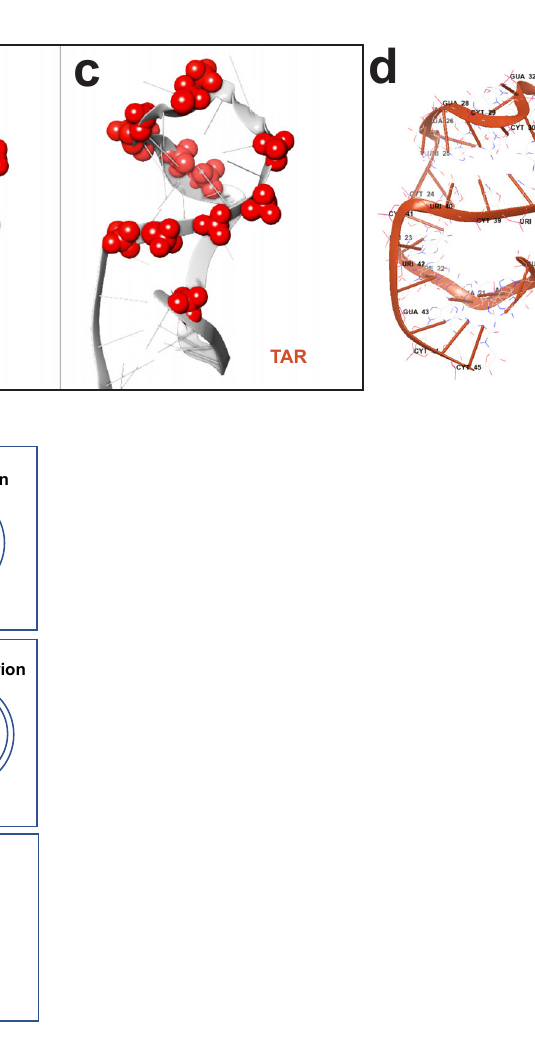
Fig. 8 TAR RNA mimicry of Rpt1 domain and model for role of INI1 during particle production. a Surface electrostatic computation of INI1 183-245 NMR structure indicating negatively (red) and positively (blue) charged and hydrophobic (white) residues. b and c Cartoon illustrating the similarity of INI1-Rpt1 to TAR RNA. Ribbon diagram of NMR structure of INI1 Rpt1 (left) where the side chains of all 11 negatively charged surface residues are depicted as red spheres, and that of TAR RNA where phosphate groups of the interacting nucleotides are depicted as red spheres. d Ribbon diagram of NMR structure of TAR RNA (PDB ID: 1ANR). e A model to understand the role of RNA mimicry of INI1 Rpt1 domain during HIV-1 assembly. Panel 1: In a producer cell where both INI1 and genomic RNA are present, INI1 acts as a place-holder and binds to IN portion of GagPol to prevent RNA binding to it, which otherwise may cause steric hindrance. Both RNA and INI1 are incorporated into the virions resulting in correct particle morphogenesis. Panel 2: RNA-interaction-defective and INI1-interaction-defective mutants of IN are impaired for binding to both RNA and INI1 and hence there is no steric hindrance for assembling GagPol. However, during particle maturation, lack of binding to RNA and/or INI1 could lead to morphologically defective particles, as shown in the empty conical capsid and unpackaged materials on the side of the capsid in the virion. Panel 3: Lack of INI1 leads to binding of RNA to IN portion of GagPol, which results in defective assembly and particle production. Gag (bright blue), RT (Reverse transcriptase; in blue), IN (wheat color), IN mutant (purple), INI1 (green), and HIV-1 RNA with TAR (red) are represented with the same colors both in the cells and in the virion particles, as indicated. Yellow, light green, and gray ovals represent possible INI1-binding